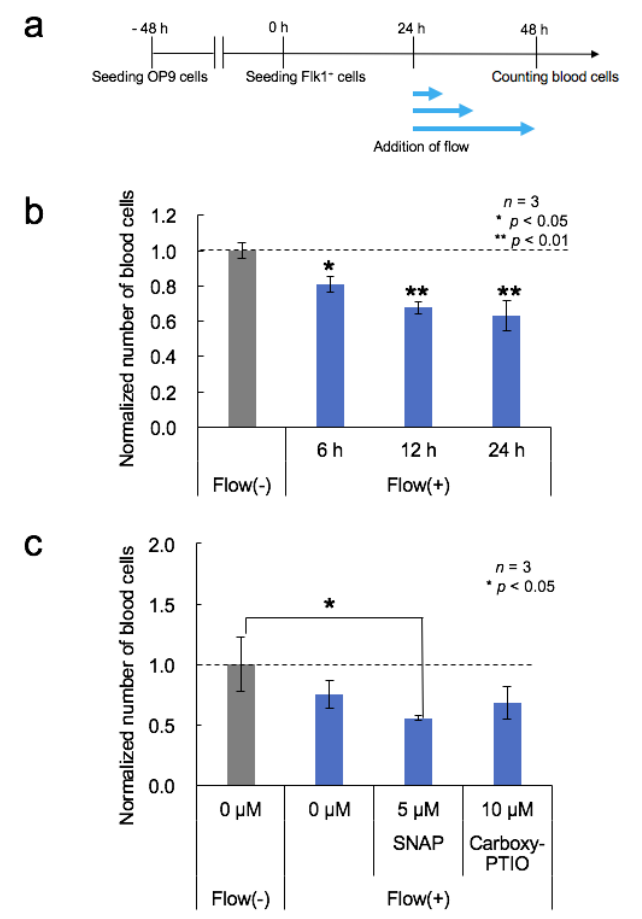
Figure 3. Effects of medium flow. ( a ) Timeline of the differentiation procedure and flow stimulation. ( b ) The number of blood cells arising from Flk-1 + cells under flow conditions with different durations. Mean ± SD, one-way ANOVA, *: p < 0.05, **: p < 0.01, n = 3. ( c ) Effects of fluid flow stress, NO donor, and NO pathway inhibitors on blood cell generation. The number of blood cells arising from Flk-1 + cells exposed to fluid shear stress of 3.3 × 10 –3 dyn/cm 2 and SNAP or Carboxy-PTIO stimulation. Mean ± SD, one-way ANOVA, *: p < 0.05, n = 3.